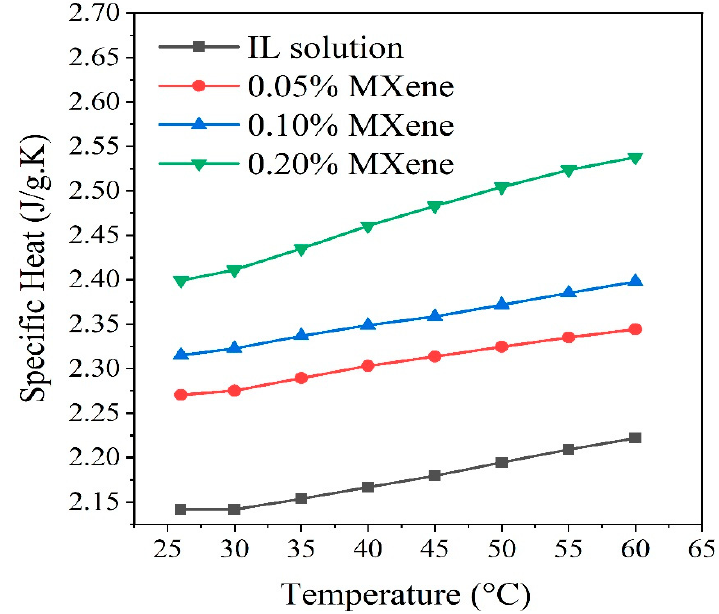
Figure 10. Specific heat capacity of IL aqueous solution and ionanofluids with various concentrations of Ti 3 C 2 .